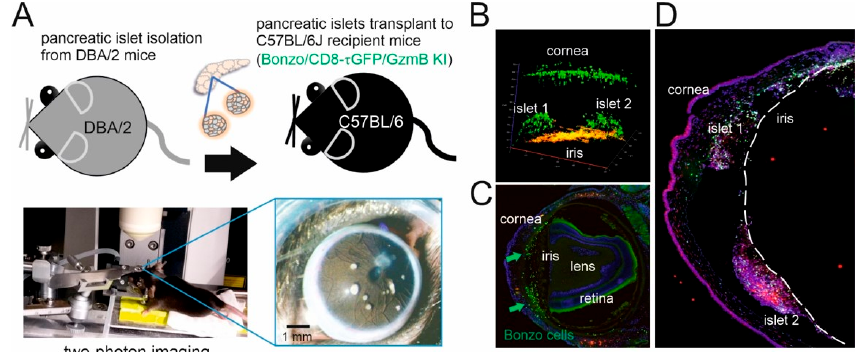
Figure 2. Immune cell infiltration during allorejection in the anterior chamber of the eye